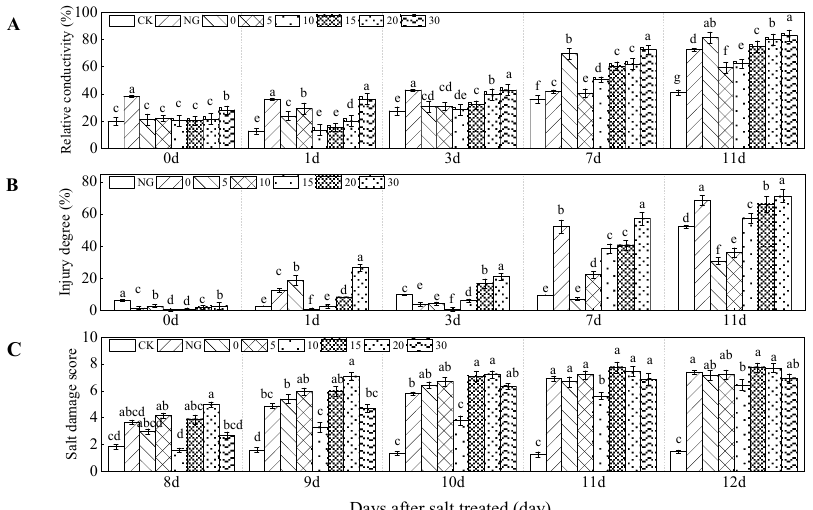
Figure 6. Free proline, malondialdehyde, and soluble sugar contents of cucumber seeding leave as affected by grafting and Ca 2+ treatments under salt stress. Bars represent standard errors. Different letters indicate a significant difference in the same parameter between treatments at p < 0.05.